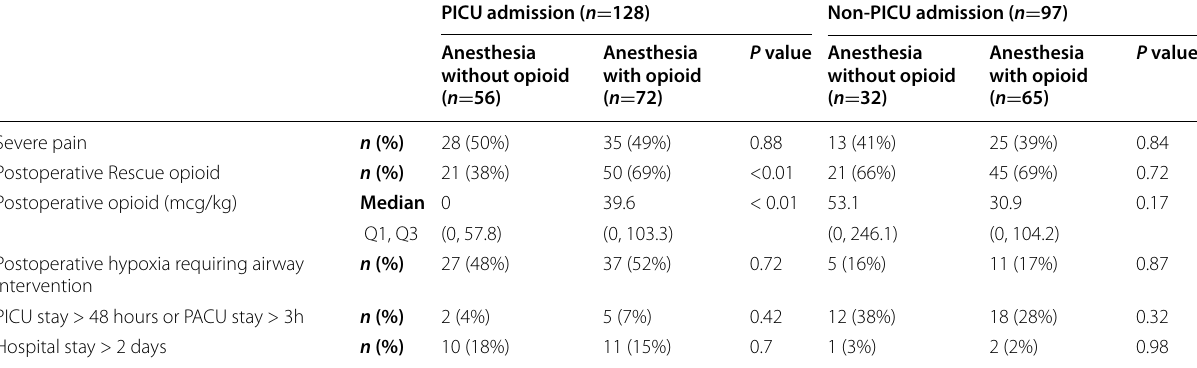
Each incident was compared between the anesthesia without opioid and with opioid groups in PICU setting and non‑PICU setting separately using the chi‑square test